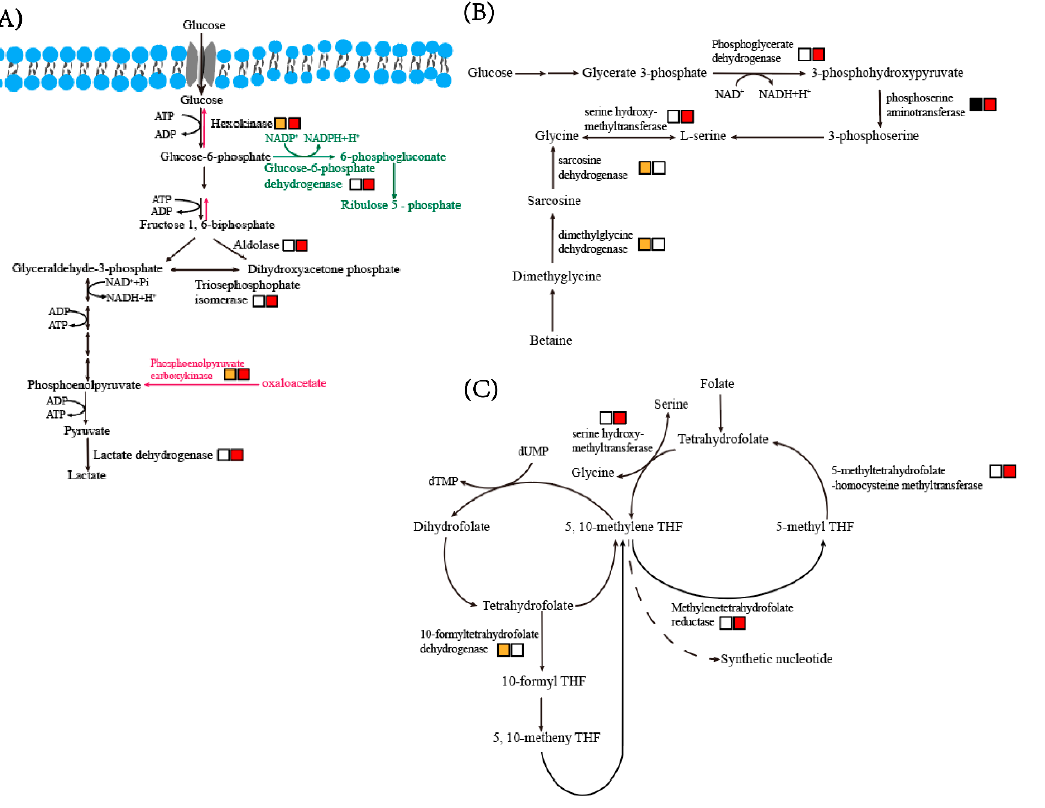
Figure 4. Expression trends of DEGs involved in metabolic pathways. ( A ) Glycolysis, gluconeogenesis (pink) and pentose phosphate pathway (green). ( B ) Glycine, serine and threonine metabolism. ( C ) One carbon pool by folate. The box shows the upregulated DEGs from the 6 hpi vs. 0 hpi comparison (orange), the upregulated DEGs from the 12 hpi vs. 0 hpi comparison (red) and the downregulated DEGs from the 6 hpi or 12 hpi vs. 0 hpi comparisons (black).